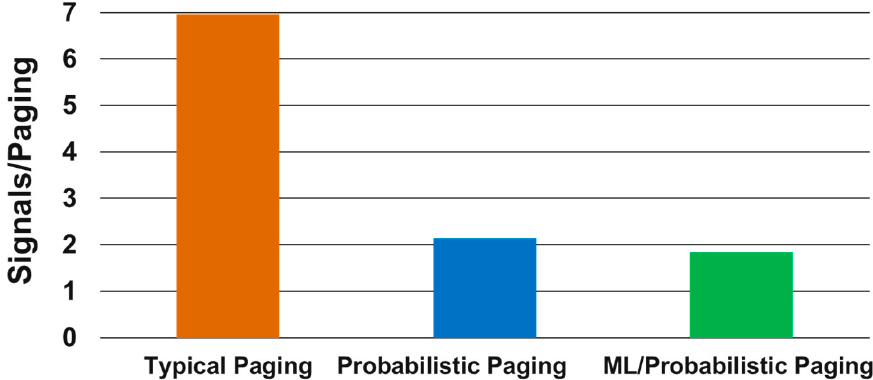
Figure 12. Total paging signals observed for different conditions of paging system.